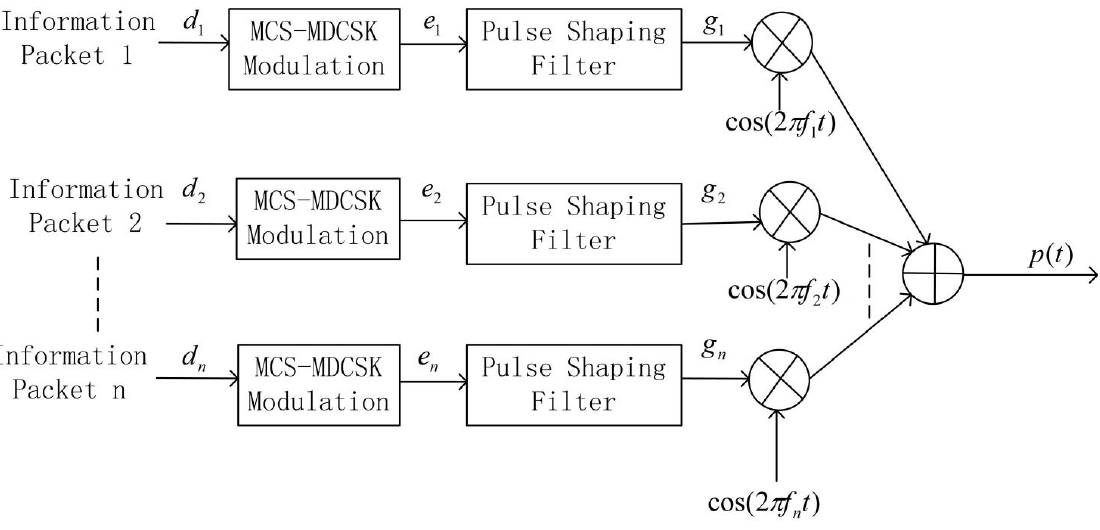
Figure 2. Block diagram of the MC-MDCSK-MCS transmitter.